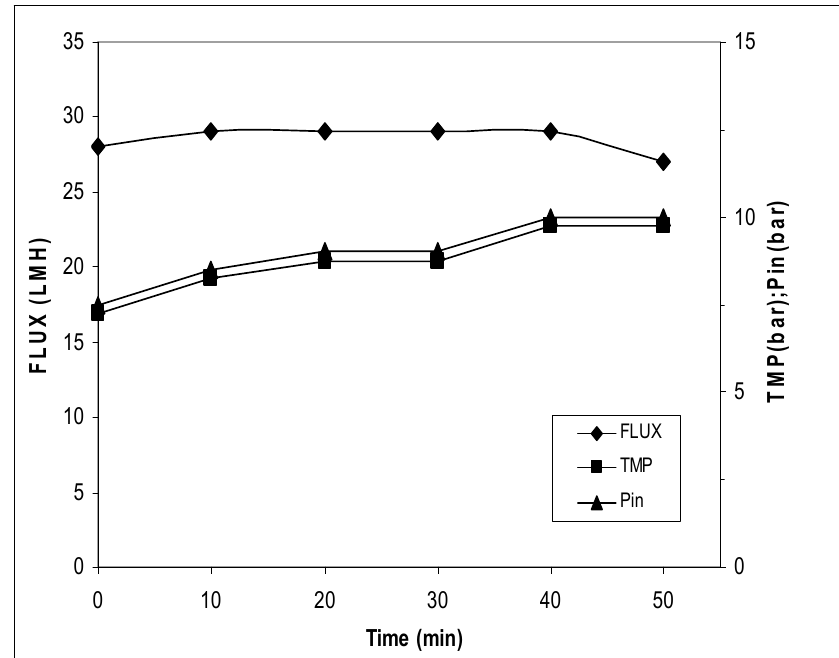
Figure 9. Transmembrane flux, corresponding TMP, and inlet pressure during the nano filtration treatment. The experiments were performed in triplicate.